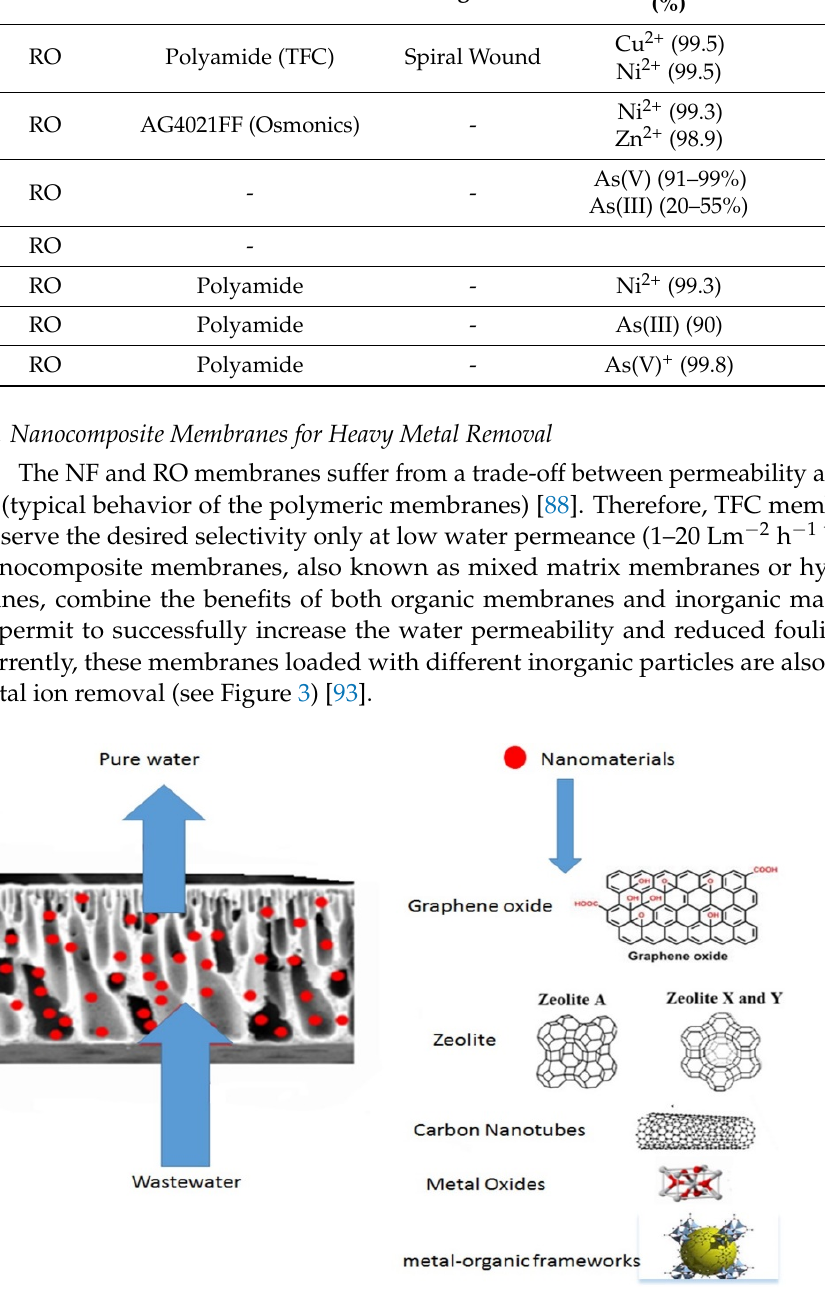
Table 10. RO membranes used for the removal of metal ions.